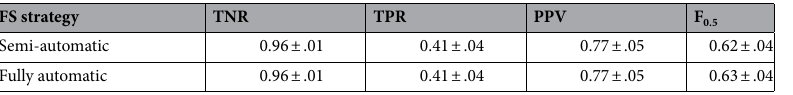
Table 1. Evaluation of the classifier performance. Estimated classification scores with 95% confidence intervals computed through averaging on a cross-validation process based on two feature selection